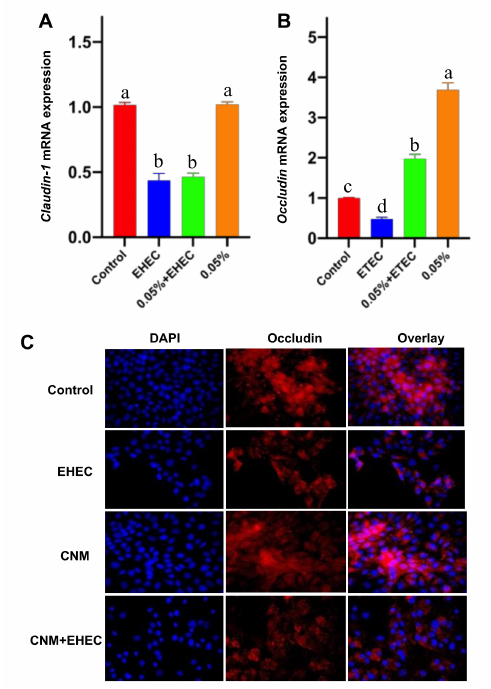
Figure 5. Effects of CNMs on the expression of tight junction proteins. Claudin-1 ( A ) and occludin ( B ) mRNA expression after E. coli O157 infection was measured by real-time PCR. ( C ) Occludin visualization expression (shown in red) and its combination with DAPI to visualize the nuclei (shown in blue). Data are means ± SEM. Means with different lowercase letters differ significantly ( p <